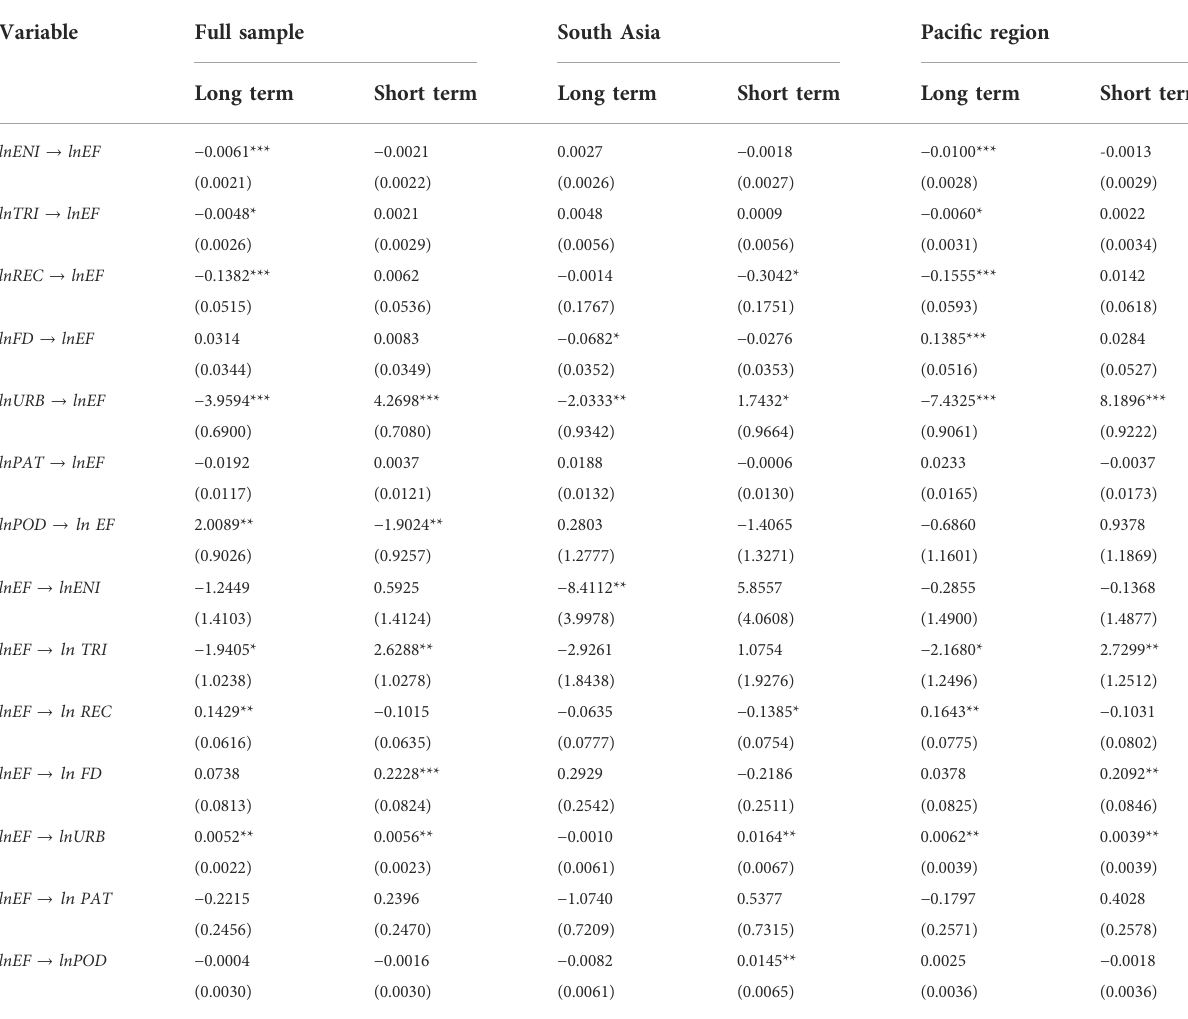
TABLE 6 Results of the Granger causality